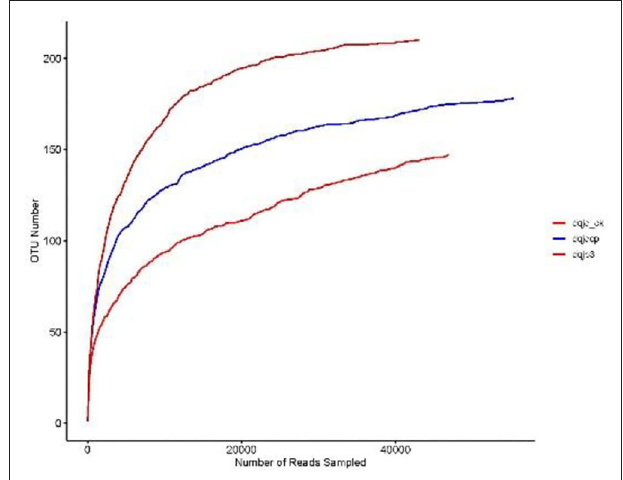
FIGURE 1 | Sparse curves of three